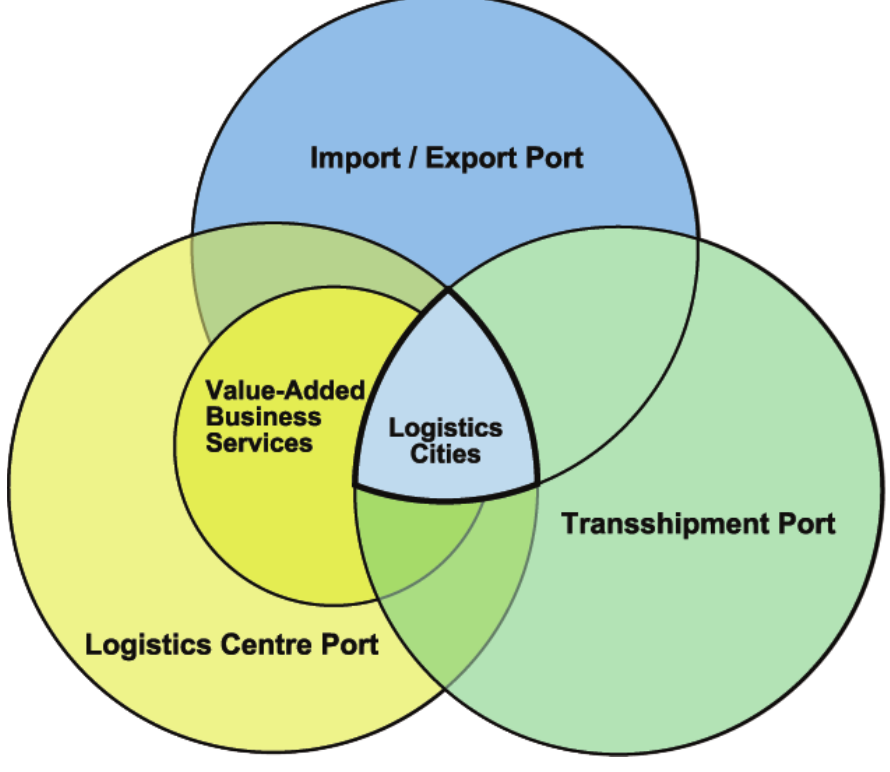
Figure 1: Port model (derived from ESCAP, 2005,